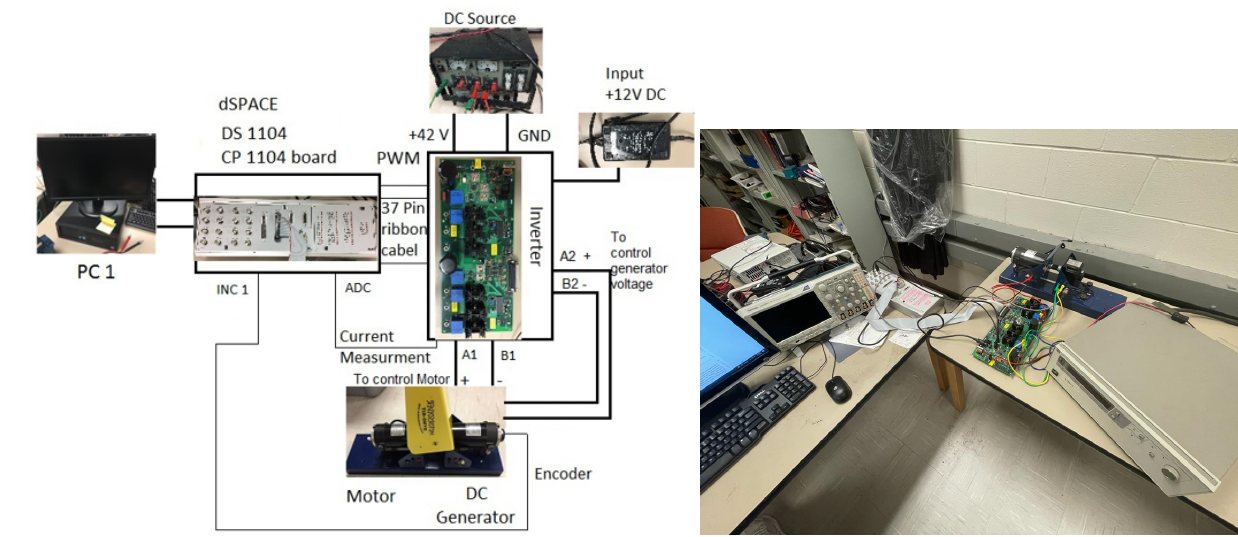
Figure 7. The experimental platform and system